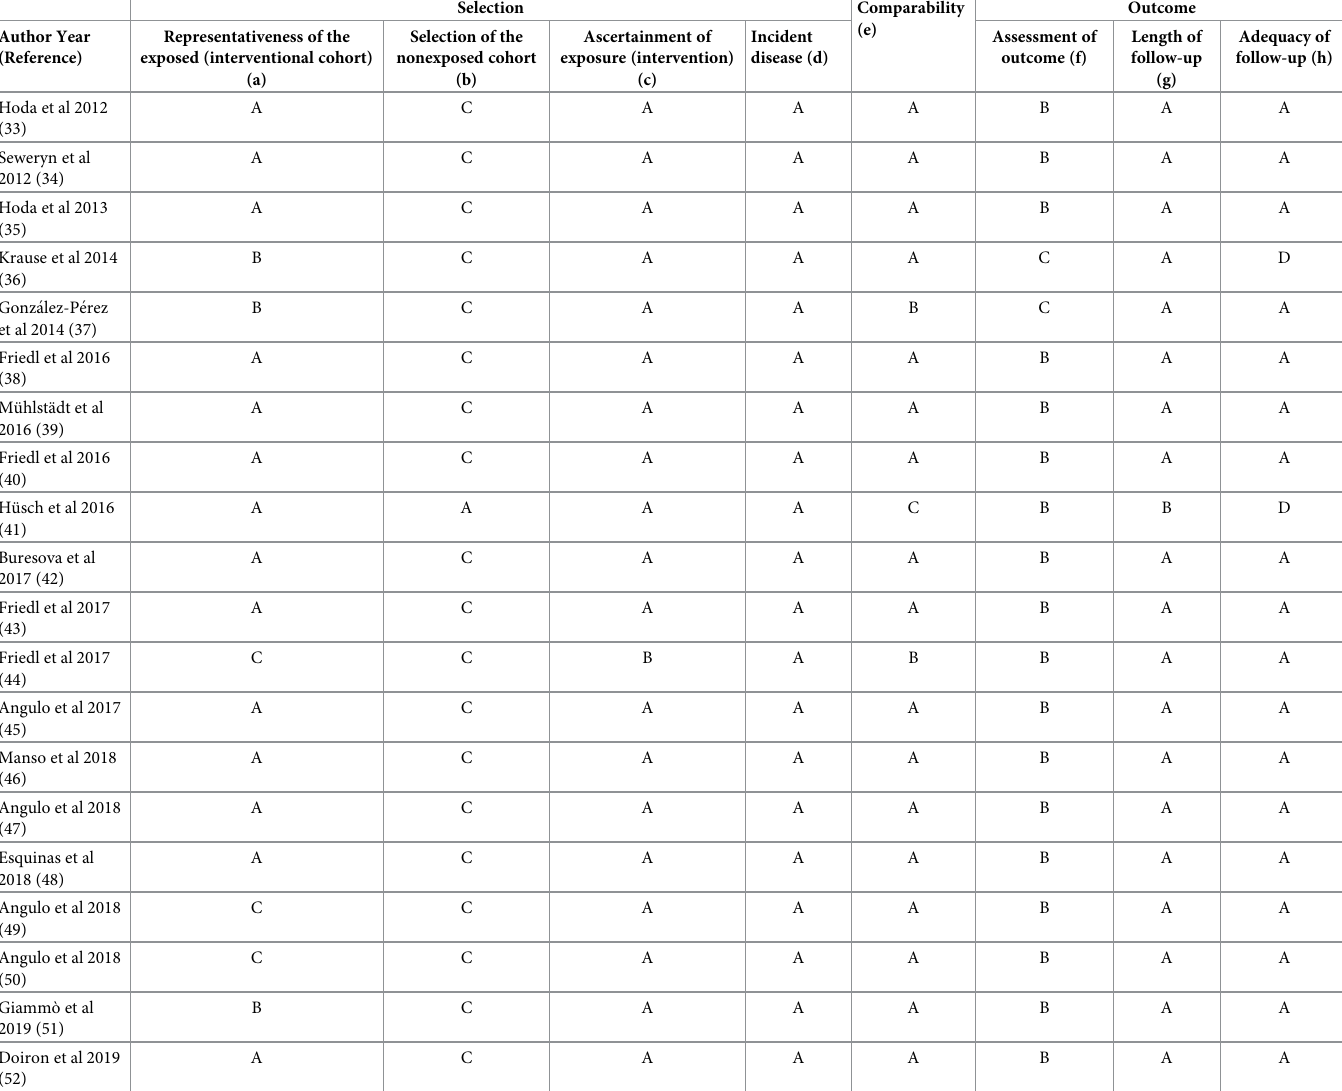
Table 5. Newcastle-Ottawa scale for assessing the quality of cohort studies with ATOMS included in the